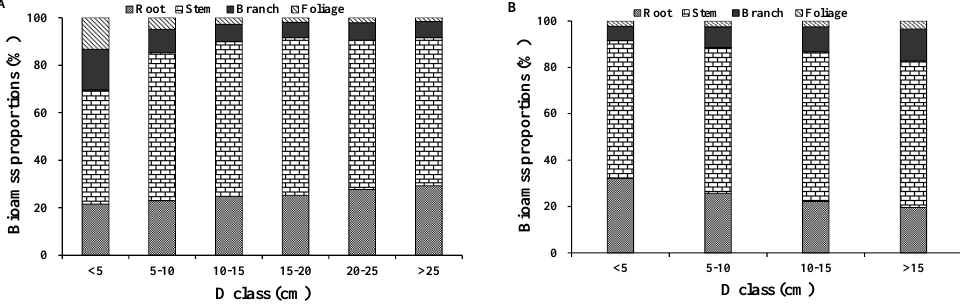
Figure 4. Biomass partitioning of the aboveground and belowground components of ( A ) Dahurian larch and ( B ) white birch across the 5-cm diameter (D) classes. Forests 2018 , 9 , x FOR PEER REVIEW